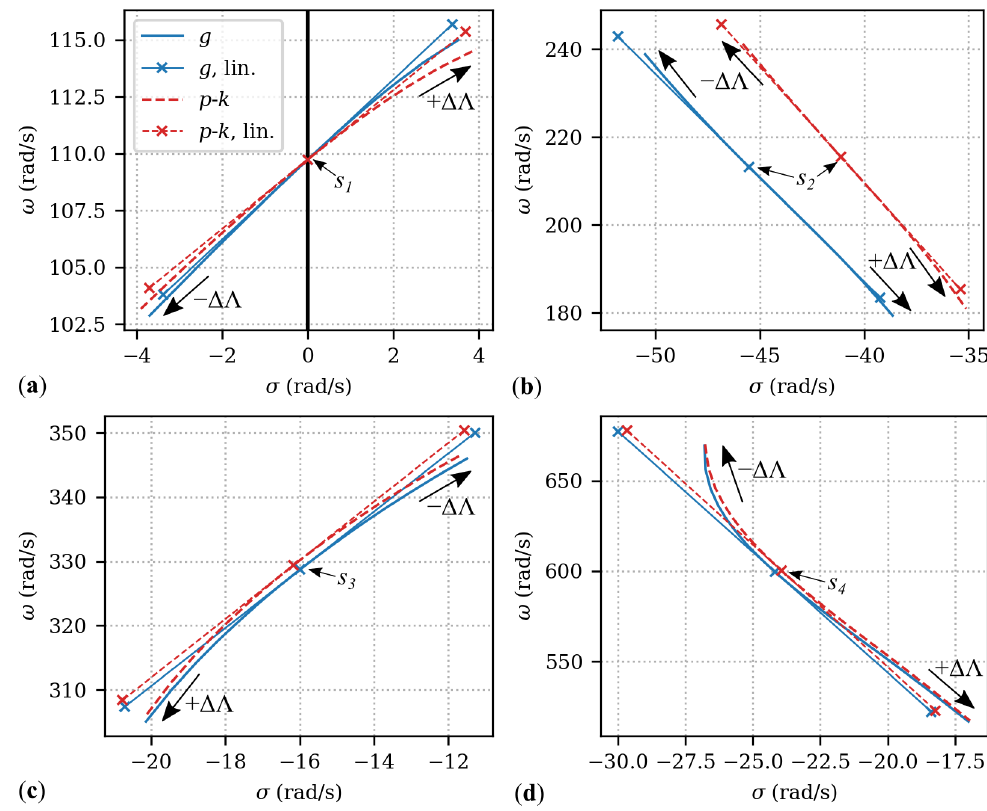
Figure 7. Eigenvalue solutions for the AGARD 445.6 weakened model employing the p - k method and the g method at V = 193.9 m/s for changing sweep angle Λ displayed in the complex plane. The eigenvalue derivatives obtained at ∆Λ = 5.9 × 10 − 5 ◦ and scaled by ∆Λ max are depicted as tangent lines at the unchanged eigenvalue solution (center ×). ( a ) First eigenvalues s 1 . ( b ) Second eigenvalues